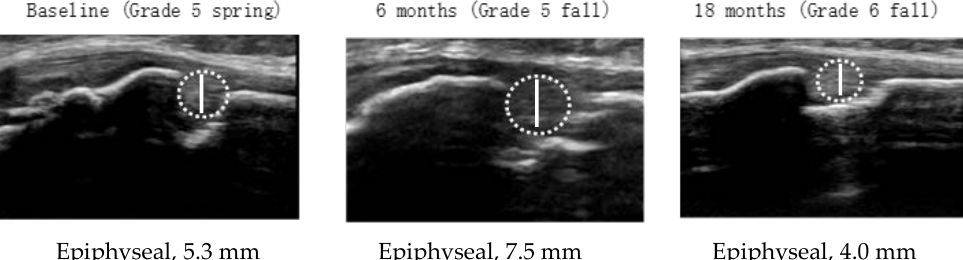
Figure 4. Ultrasound image, maturity stage, and cartilage thickness at each examination time point of the student who developed Osgood–Schlatter disease in grade 5 fall. Cartilage swelling and an irregular contour of the tibial tuberosity are observed in grade 5 fall. However, these findings are not observed in grade 6 fall. Chronic pain had disappeared by grade 6 fall.